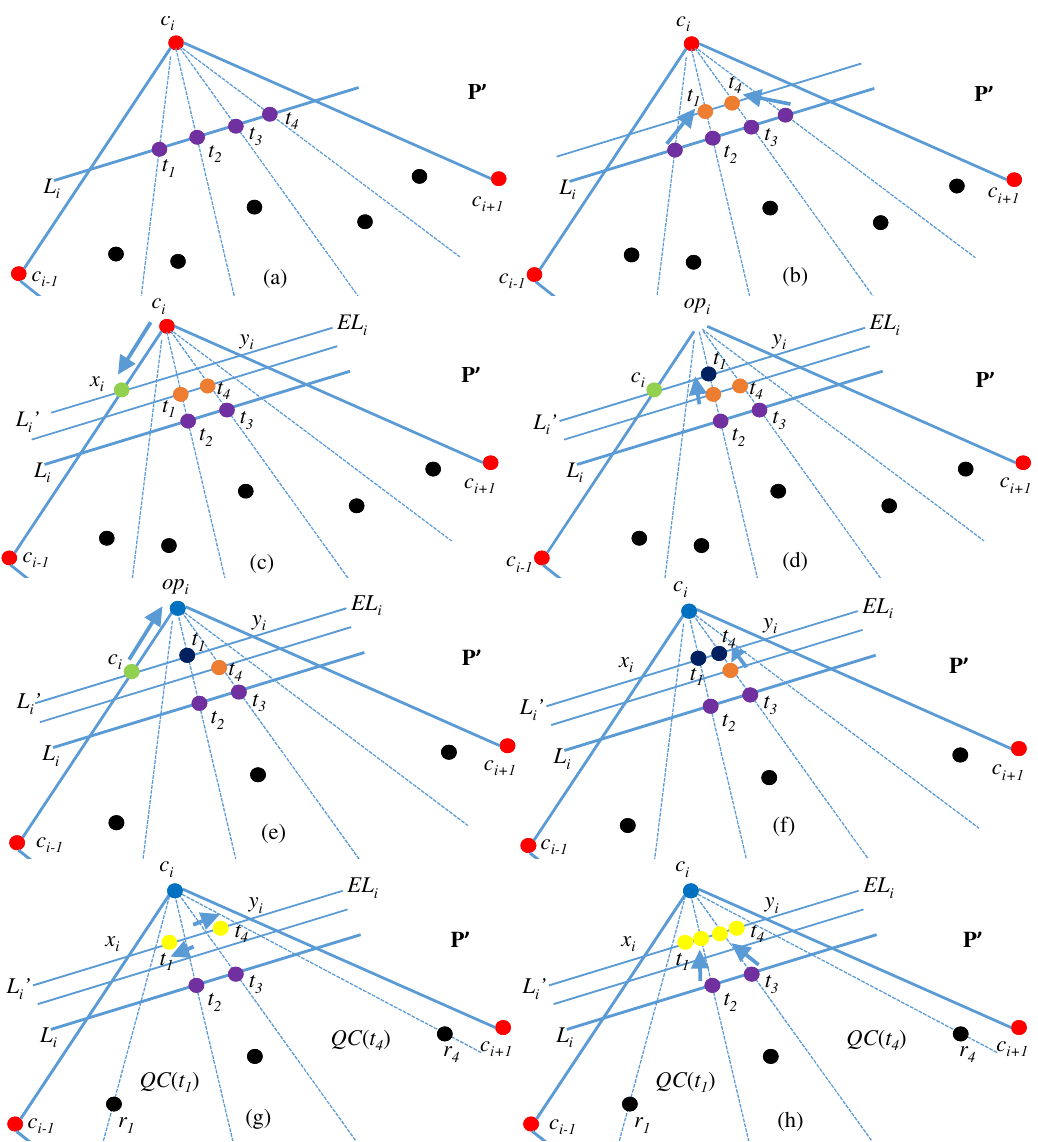
Figure 11. An illustration of how the corner and interior robots of P (cid:48) move during Stage 1.2.1.2: ( a ) four robots on line L i which is either a corner line segment CL i or a triangle line segement TL i ; ( b ) two robots from L i moving to a line parallel to L i towards corner c i ; ( c ) corner c i moving to EL i on the intersection point of EL i and c i c i − 1 ; ( d ) one orange robot moves to EL i ; ( e ) corner robot c i now moves back to the corner; ( f ) another orange robot moves to EL i ; ( g ) the orange robots on EL i move away from each other making room for two robots on L i to move to it; and finally ( h ) fours robots are on EL i